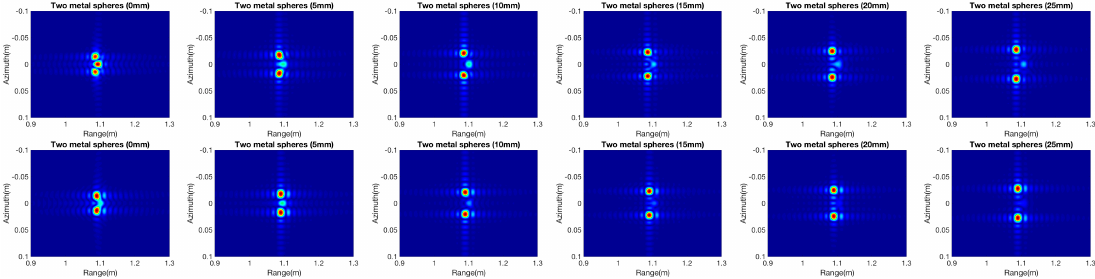
Figure 15. Case simulations of two metal spheres in the monostatic and bistatic modes with spacing of 0 mm, 5 mm, 10 mm, 15 mm, 20 mm and 25 mm. ( top : monostatic and bottom : bistatic).